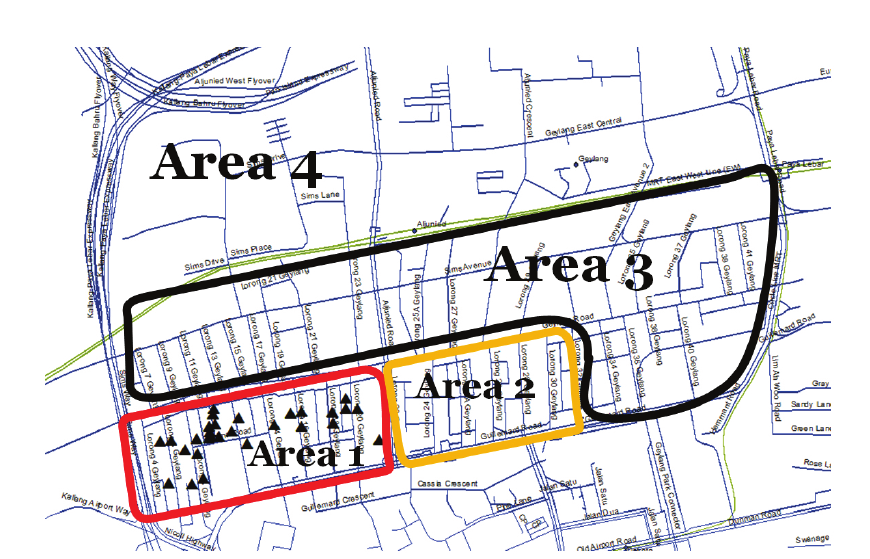
Figure 2. Details of Aljunied Subzone,